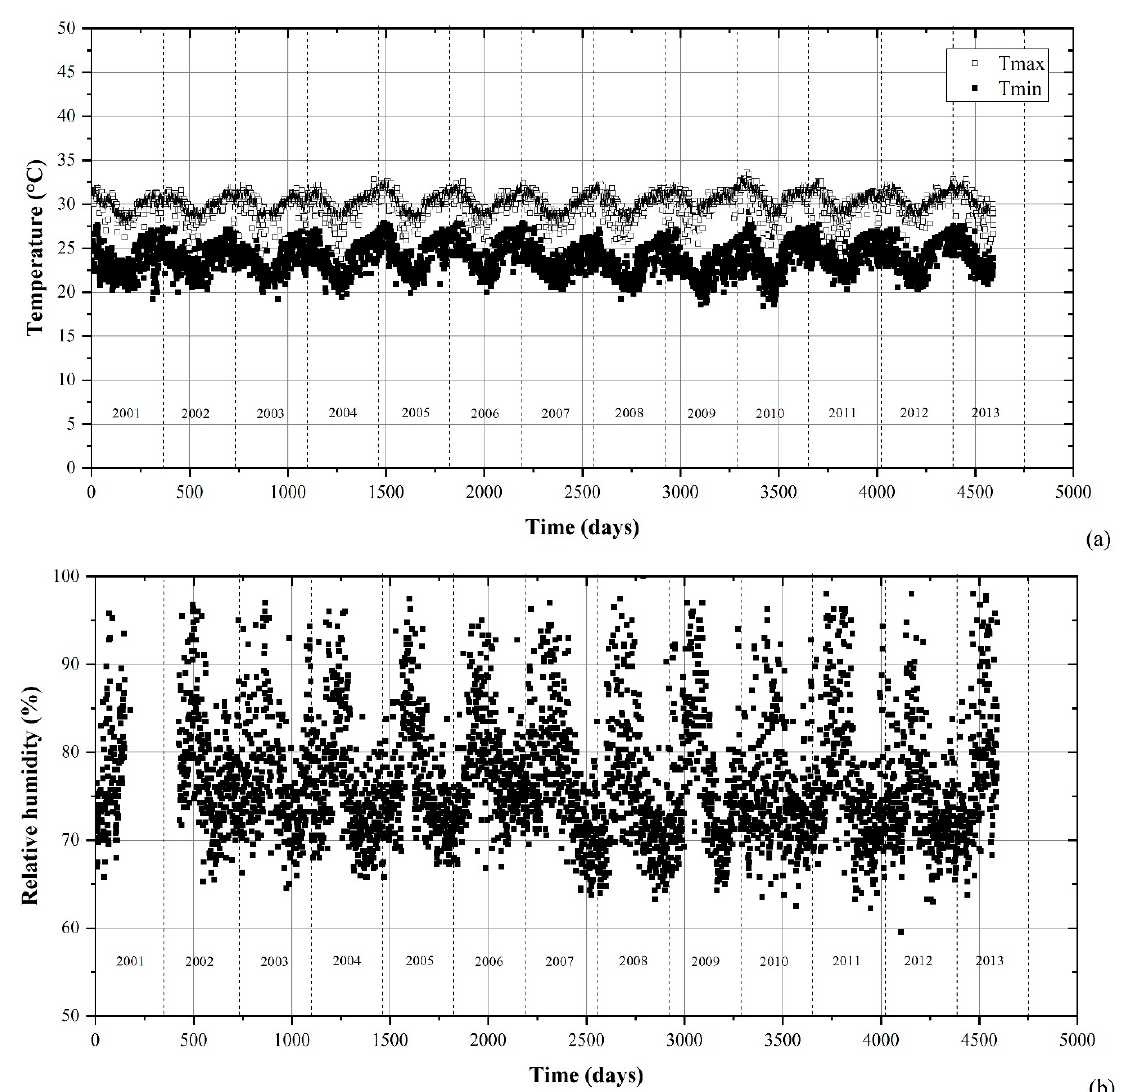
Figure 4. Maximum and minimum daily temperature ( a ) and daily average relative humidity ( b ) in the exposure region.